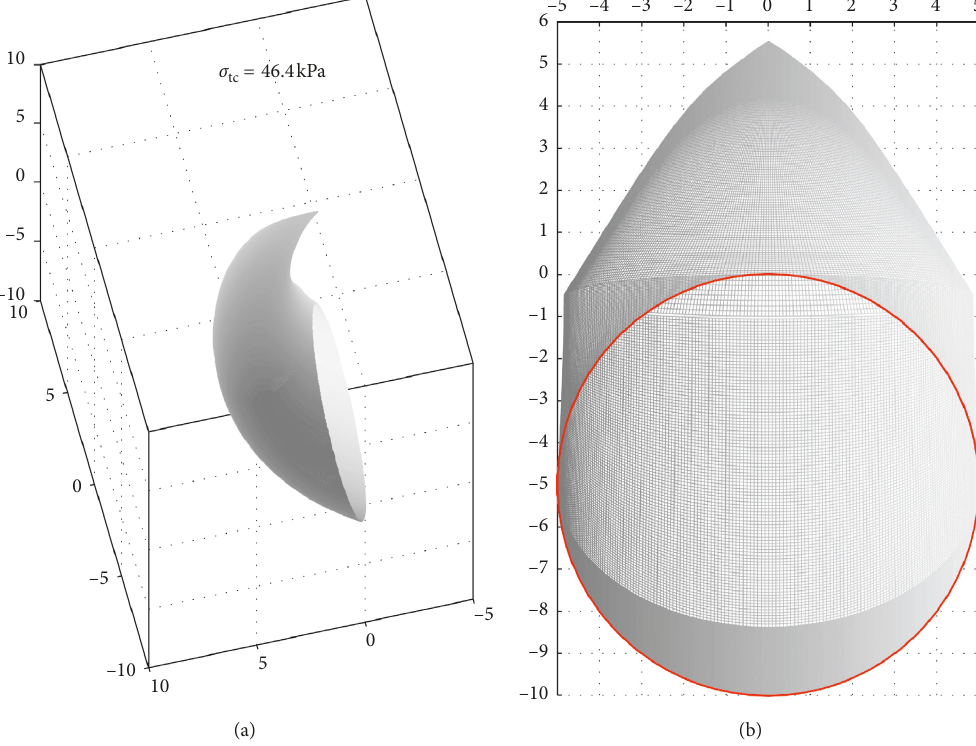
Figure 6: View of the critical failure surfaces of tunnel face in cohesive frictional soil with c